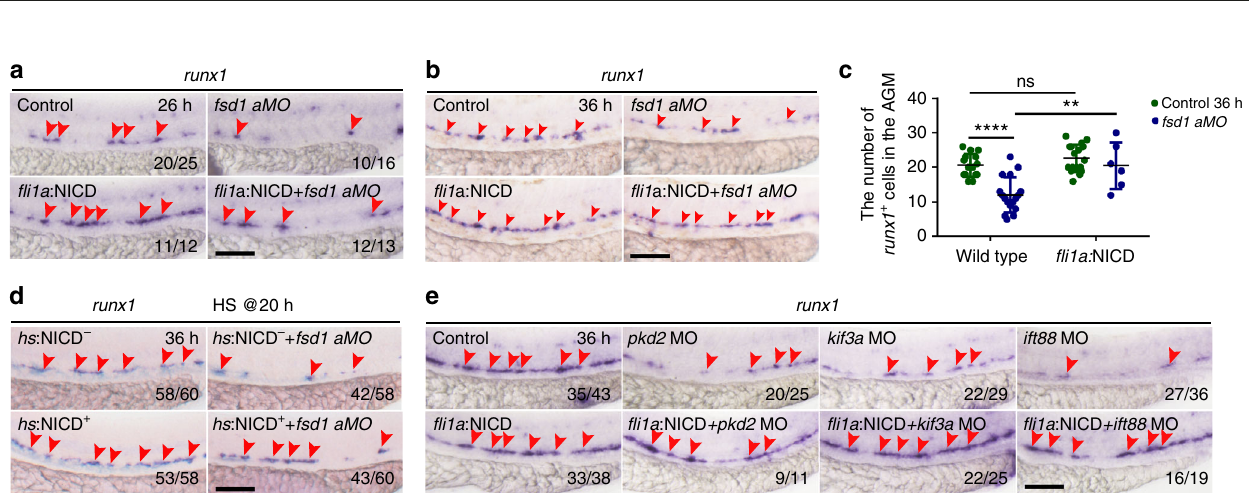
Fig. 6 Notch signaling is downregulated in hemogenic endothelium (HE) cells in primary cilia-impaired embryos. a The gene ontology analysis for the downregulated genes in fsd1 morphants. b Volcano plot showing the dysregulated genes between wild-type embryos and fsd1 morphants at 26 hpf. Endothelial cell markers kdrl and fl i1a , arterial markers including ephrinB2a , dll4 , and hey2 , and Notch signaling components including notch1a , notch2 , notch3 , maml1 , jag1a , and adam10b are highlighted in black. Red arrows denote the gene location site. c qPCR result of Notch target genes in wild-type embryos and fsd1 mutants at 26 hpf. Error bars, mean ± s.d., * P < 0.05, ** P < 0.01, **** P < 0.0001, ns non-signi fi cant, Student ’ s t -test. n = 3 biological replicates. d Western blotting showing the protein level of NICD in wild-type embryos and fsd1 − / − at 26 hpf. e Expression of notch1a in kdrl + runx1 + cells in the AGM in control and fsd1 morphants at 26 hpf. Error bars, mean ± s.d., ** P < 0.01, ns non-signi fi cant, Student ’ s t -test. n = 3 biological replicates. f , g Confocal imaging of Tg ( tp1 :mCherry/ fl i1a :EGFP) embryos in the AGM region in control and cilia-impaired embryos at 26 hpf. tp1 :mCherry + / fl i1a :EGFP + double positive cells (white arrowheads) were quanti fi ed in g . Scale bar, 50 µ m. Data represent the analysis results of one-way ANOVA – Dunnett test. Error bars, mean ± s.d., n = 12, 9, 7, 10 embryos, ** P < 0.01,*** P < 0.001, **** P < 0.0001. h Immuno fl uorescence staining of RPE-1 cells with acetylated α -tubulin (Ac-tubulin, cilia marker) antibodies and Hoechst (DNA marker) in ciliated and non-ciliated cells treated with siCtrl and si FSD1 respectively. RPE-1 cells were transfected with GFP-NICD plasmid and indicated siRNA. The nuclei were stained with Hoechst (blue) and the cilium was marked by Ac-tubulin (red). The GFP indicated the NICD expression. Scale bar, 5 µ m. i Western blotting showing the protein levels of NICD, β -actin and FSD1 in GFP-NICD plasmid transfected in siCtrl or si FSD1 RPE-1 cells. j , k Quanti fi cation of GFP-positive cells with nuclear NICD ( j ) or with primary cilia ( k ) in h . Data are presented with three